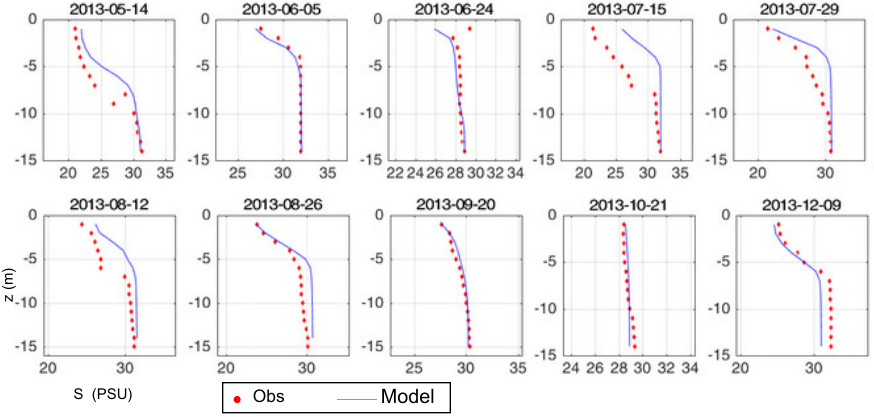
Figure 10. Typical vertical salinity profiles showing the stratified-mixed-stratified cycles at CB7.4 (near the Bay mouth, see the exact location in Figure 1).